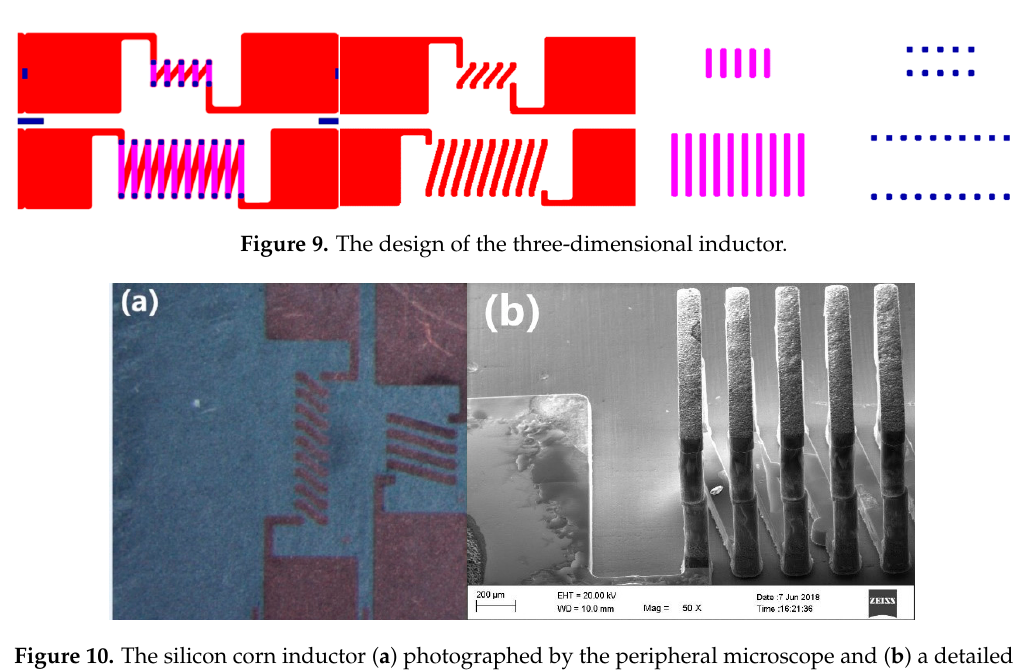
Figure 8. Three-dimensional (3D) inductor manufacturing steps: ( a ) TSVs were etched and a SiO 2 insulation layer was deposited. ( b ) The adhesion layer (Cr, 30 nm) and seed layer (Cu, 300 nm) were sputtered and electroplated copper covered the TSVs. ( c ) Electroplated copper was grown in TSVs. ( d ) The copper layer was sputtered on the top side. ( e ) The TSVs were fully filled and ( f ) the silicon substrate was removed.